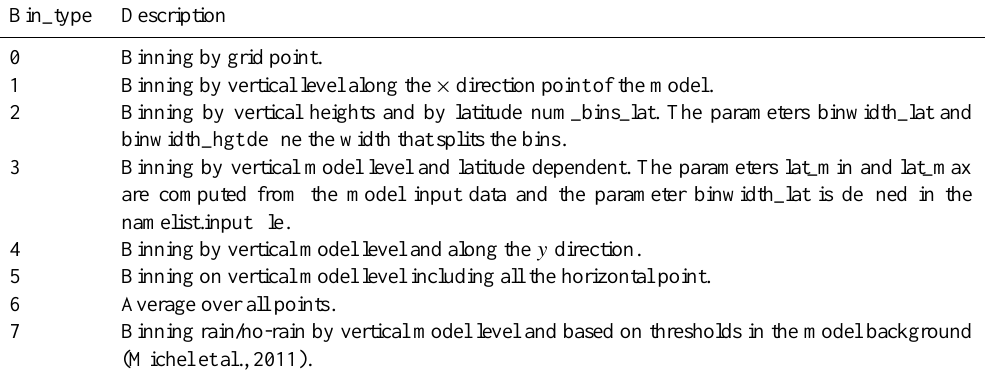
Table B2. Description of the binning options.